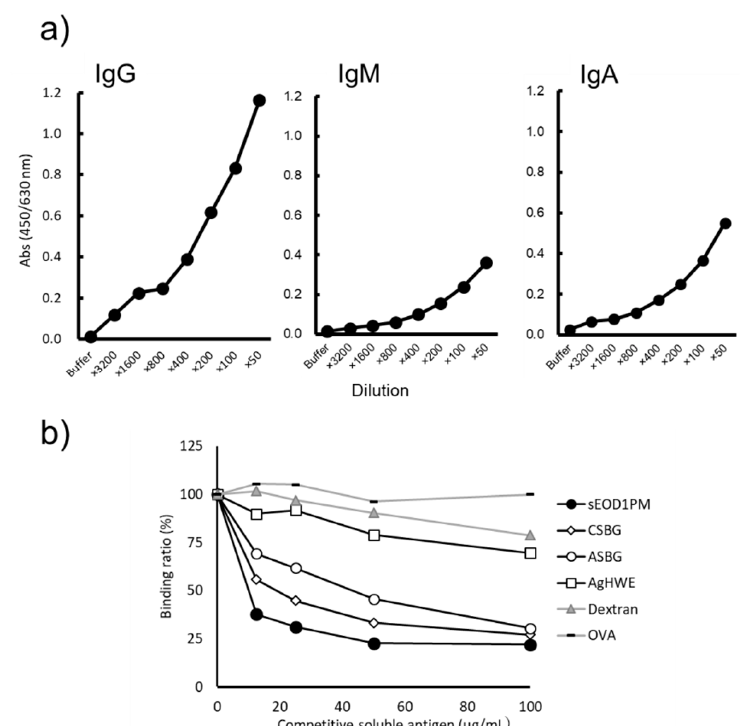
Figure 4. Class of antibody against Euglena gracilis EOD-1 paramylon (EOD1PM) in human sera and specific reactivities. ( a ) Reactivity of anti-sEOD1PM immunoglobulin (Ig) G, IgM, and IgA antibody in human sera. An ELISA plate was coated with solubilized EOD1PM (sEOD1PM) and blocked. Sera were diluted, and the amount of plate-bound Ig was determined using the detection antibody; ( b ) Specificity of the anti- sEOD1PM IgG antibody in human sera. An ELISA plate was coated with sEOD1PM and blocked. Human sera were mixed with serially diluted competitive soluble antigen and then applied to the ELISA plate. The amount of plate-bound Ig was determined using the detection antibody. AgHWE: Polysaccharide fractions from Agaricus brasiliensis ; ASBG: solubilized cell wall glucan from Aspergillus niger .